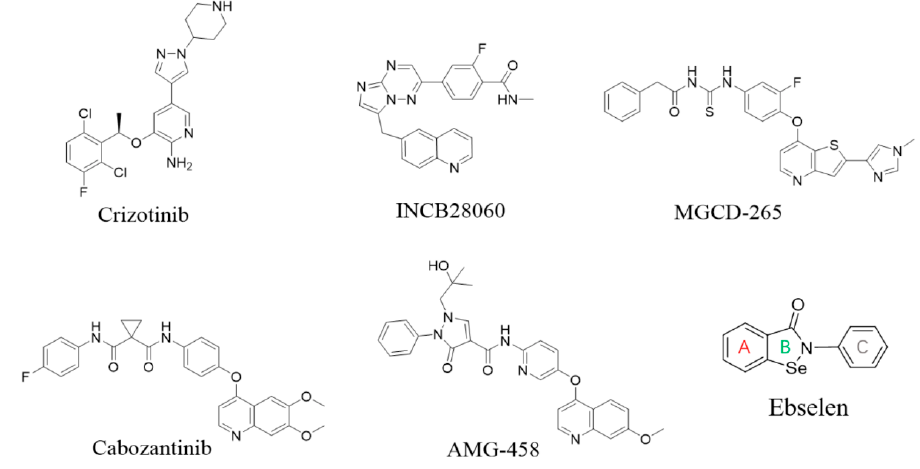
Figure 1. Structure of the known c-Met inhibitors and Ebselen.